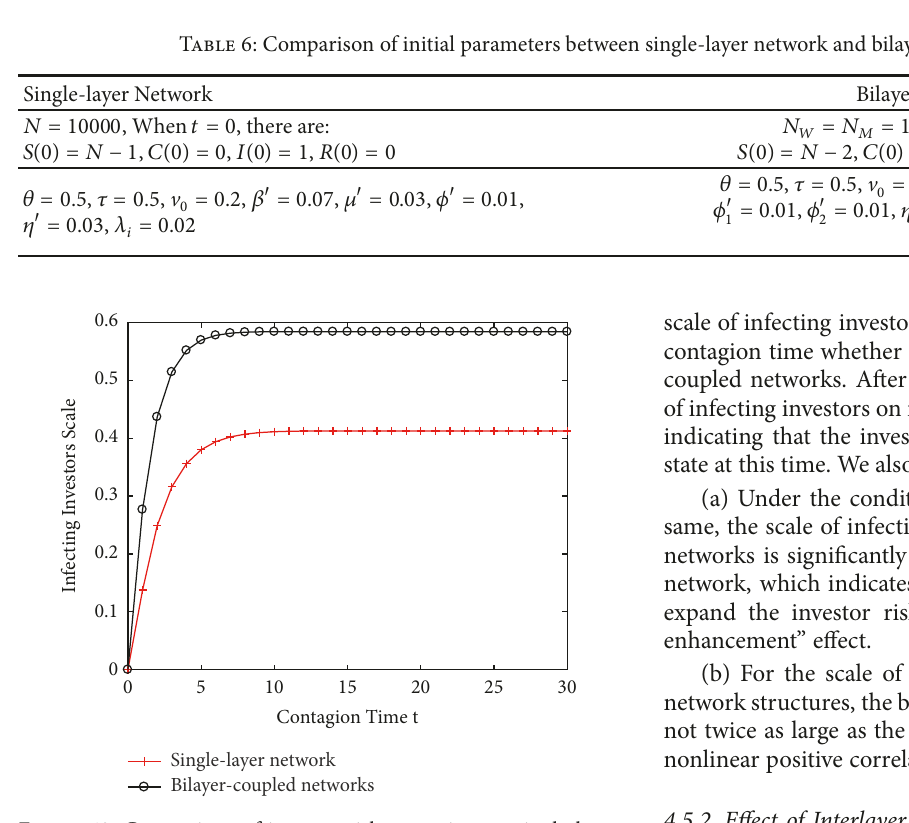
Figure 13: Comparison of investor risk contagion on single-layer network and bilayer-coupled networks in the stock